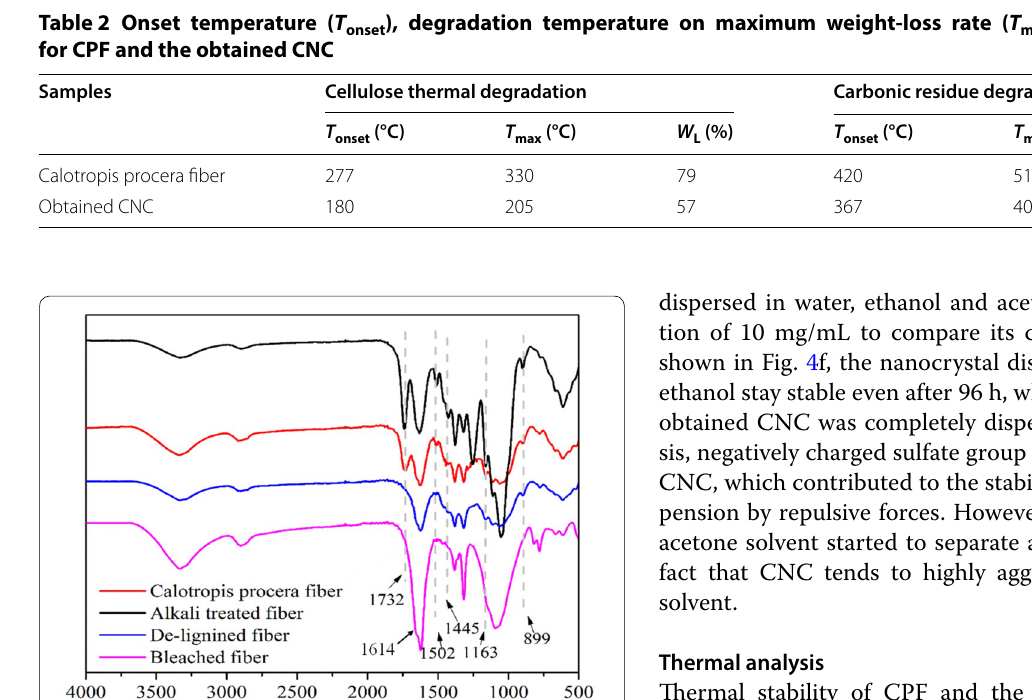
), weight loss ( W ) max L